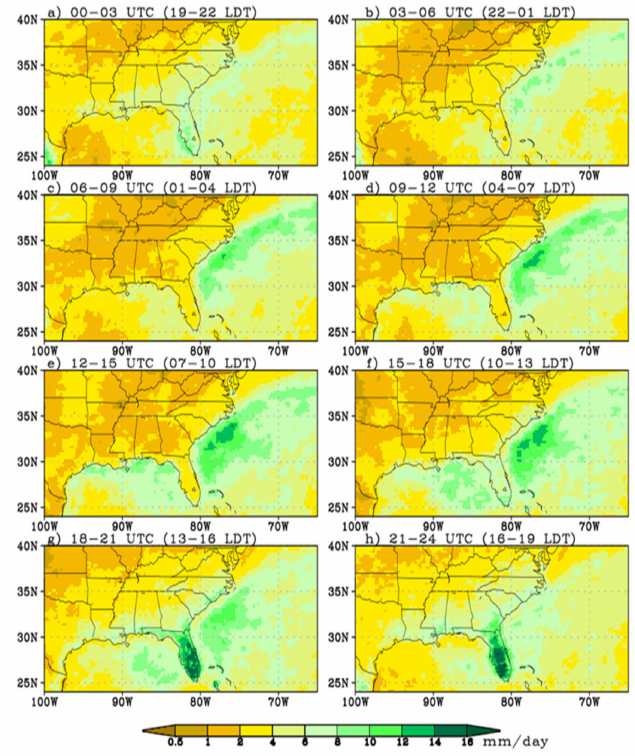
Figure 11. Same as Figure 7, but for WT5.